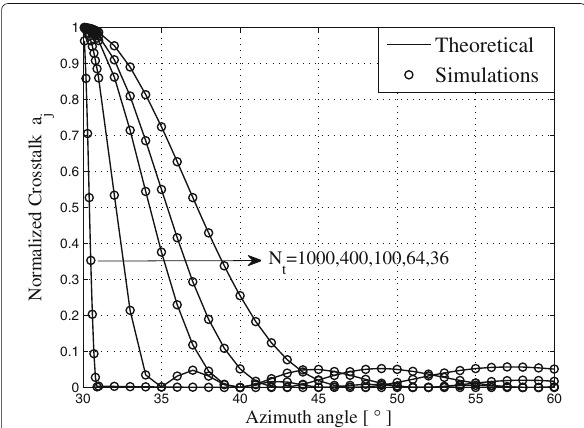
Fig. 2 The normalized crosstalk coefficient versus the azimuth angle of the j -th user for different N t